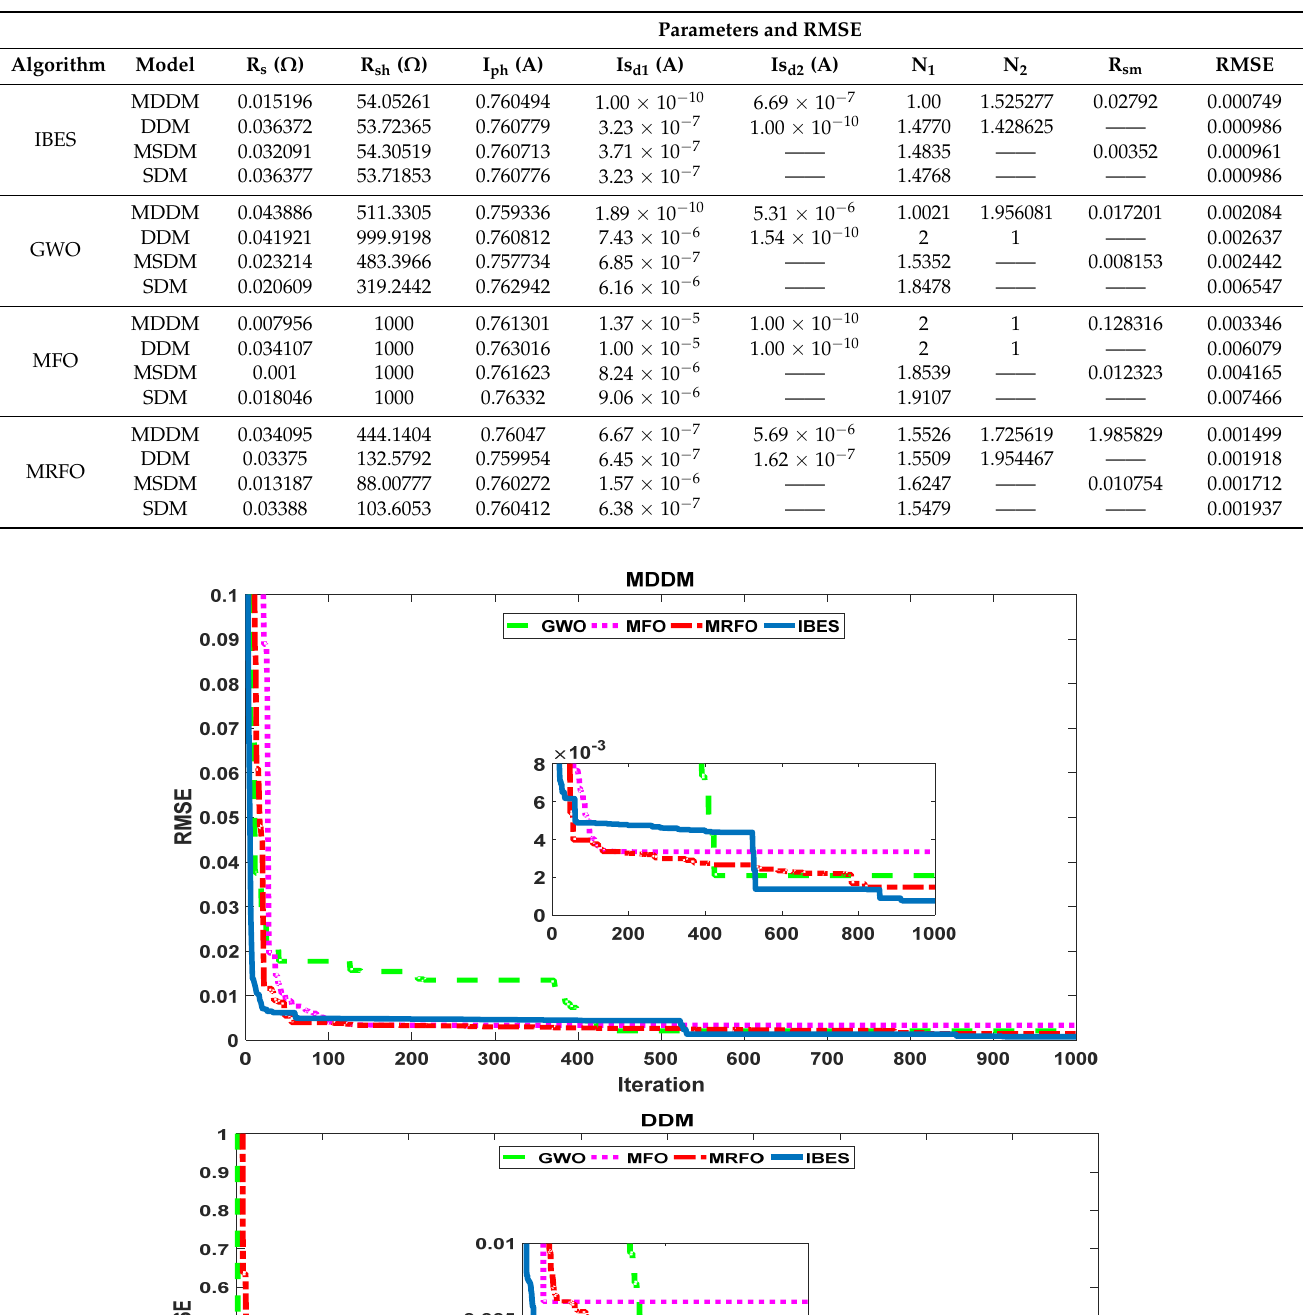
Table 8. Estimated parameters and RMSE values of the IBES, GWO, MFO, and MRFO applied to the MDDM, DDM, MSDM, and SDM.